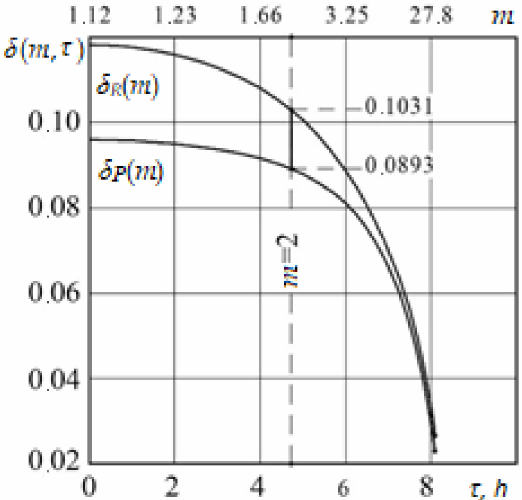
Figure 2. Correlation between optical thicknesses of air δ R ( m ), and δ P ( m ); (own